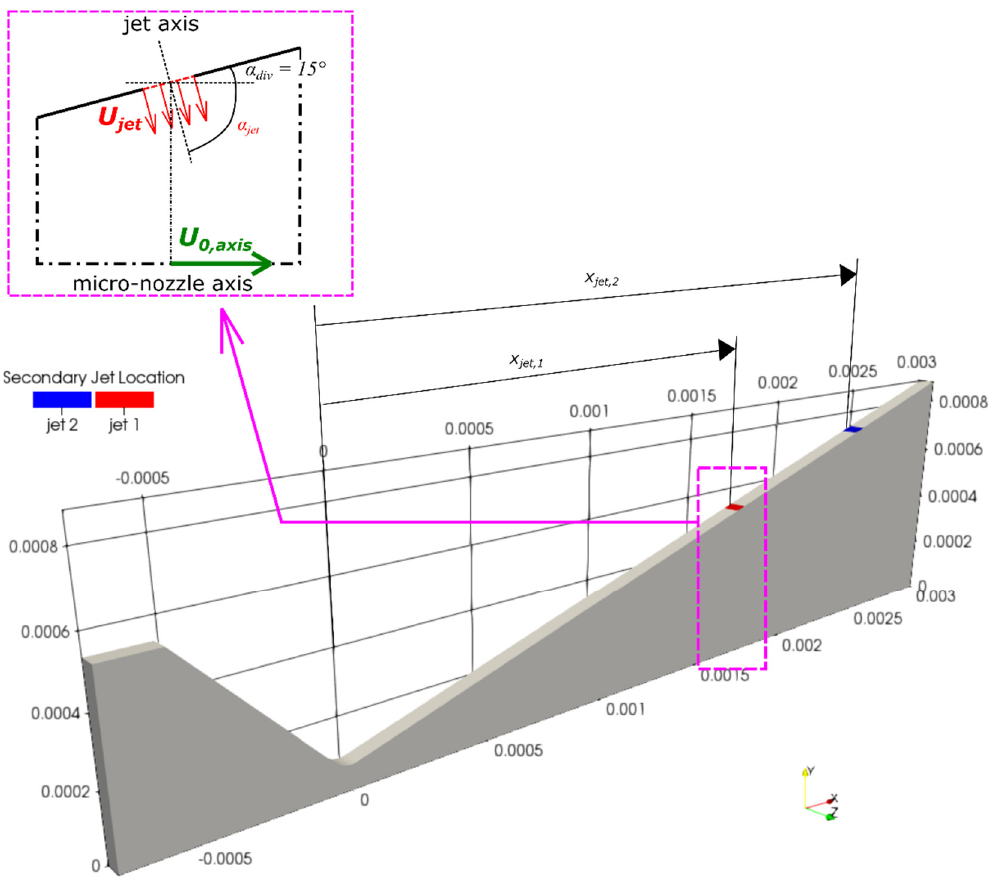
Figure 2. Computational domain with indication of the secondary jet location. Table 2. Secondary injection